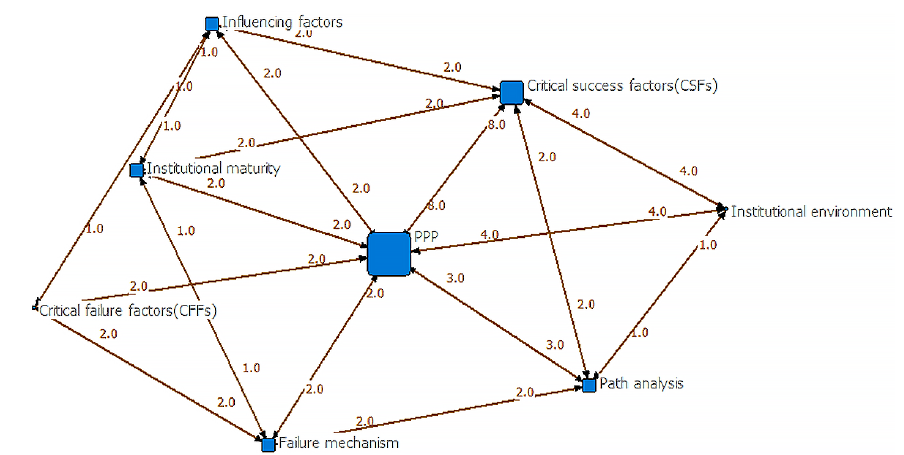
Figure 5. Contract management topics in PPP